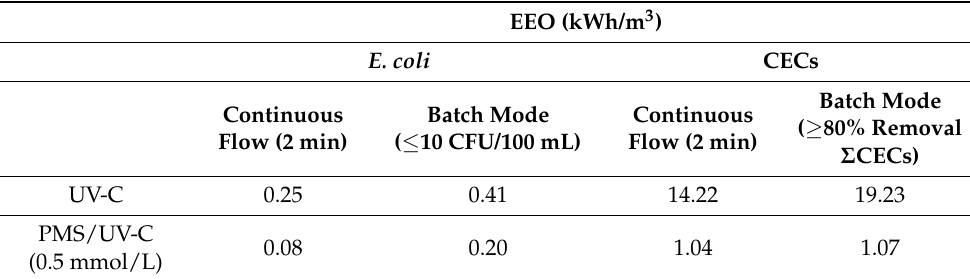
Table 2. Energy per order (EEO, kWh/m 3 ) for UWW treatment (disinfection and CECs removal) in continuous flow (one path throughout lamp) and batch conditions by UV-C and PMS/UV-C (0.5 mmol/L)